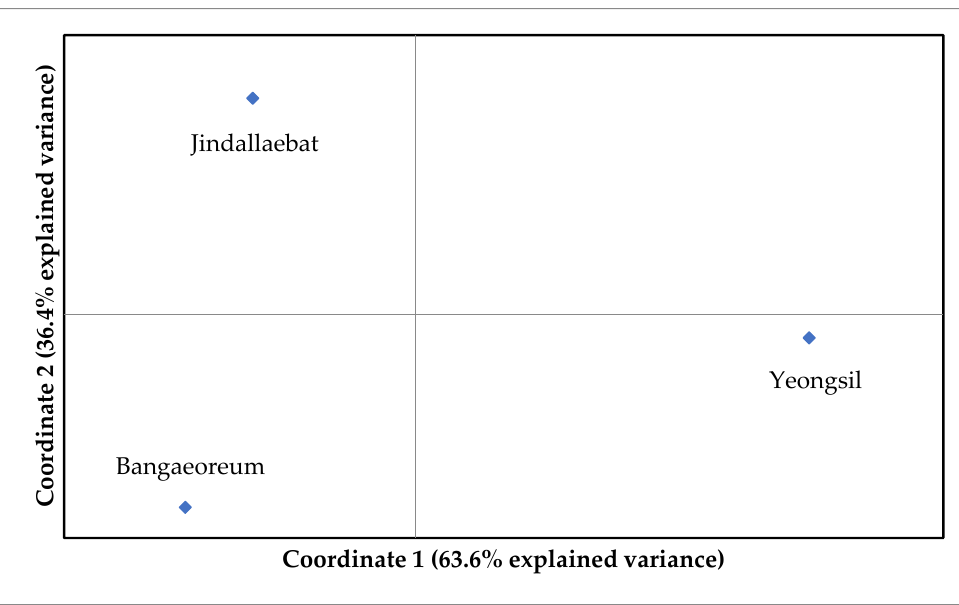
Figure 2. Principal co-ordinate analysis of the genetic distances among the three subpopulations of Abies koreana on Mt. Hallasan.